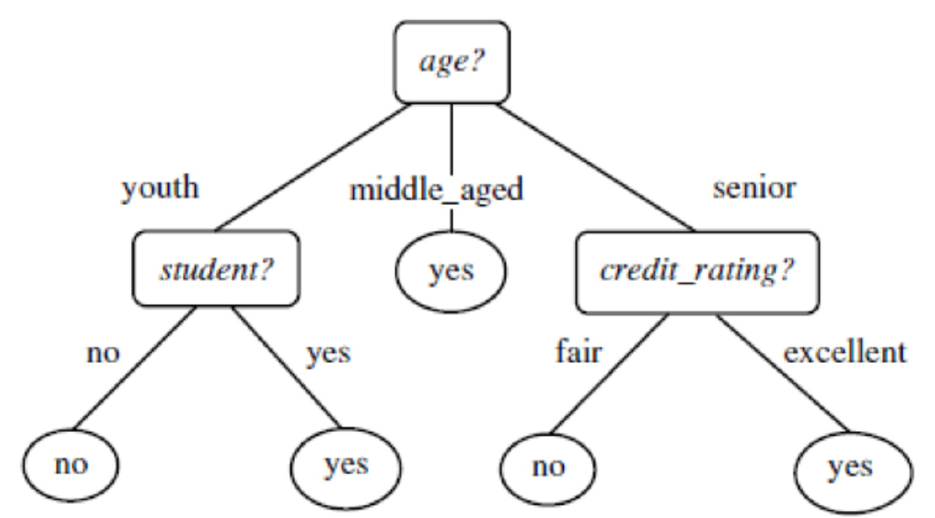
Figure 2. The concept of decision tree.